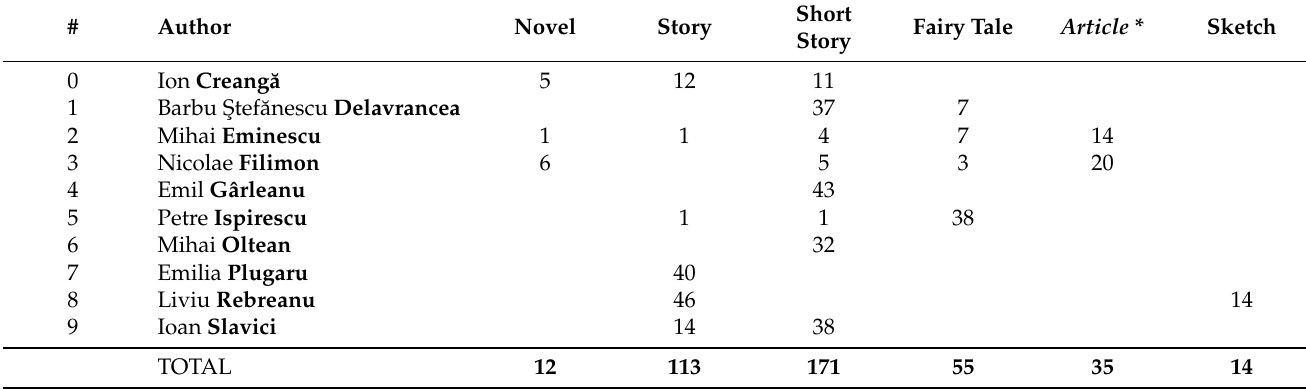
Table 7. List of authors and types of writing of the considered texts. Author is the author’s name (the last name is in bold); Article ∗ include, in addition to articles written for various newspapers and magazines, other types of writing that did not fit into the other categories, but relate to this category, such as prose , essays , and theatrical or musical chronicles . Total number of texts per type are in